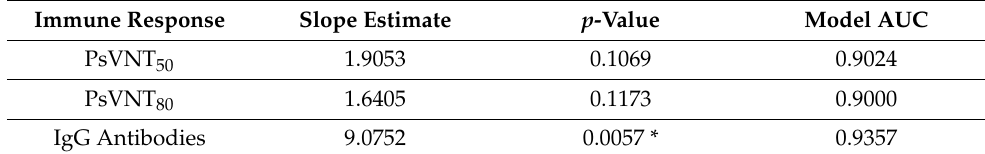
Table 2. Fitted logistic model results for survival as a function of immune response.